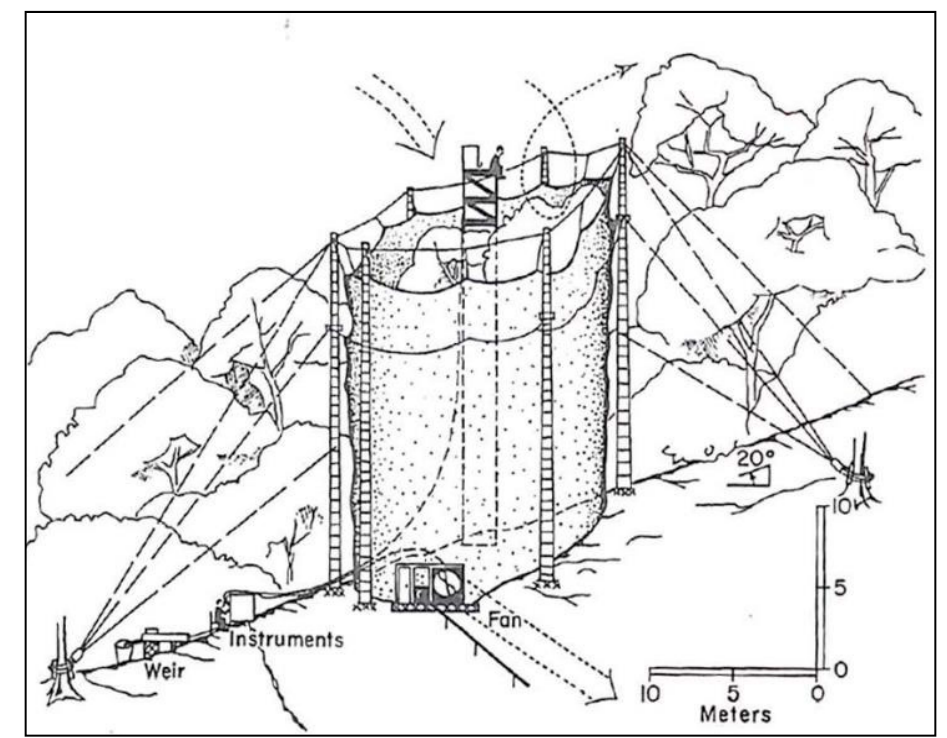
Figure 4. Schematic diagram of the Big Plastic Cylinder Experiment. Reproduced from [16].